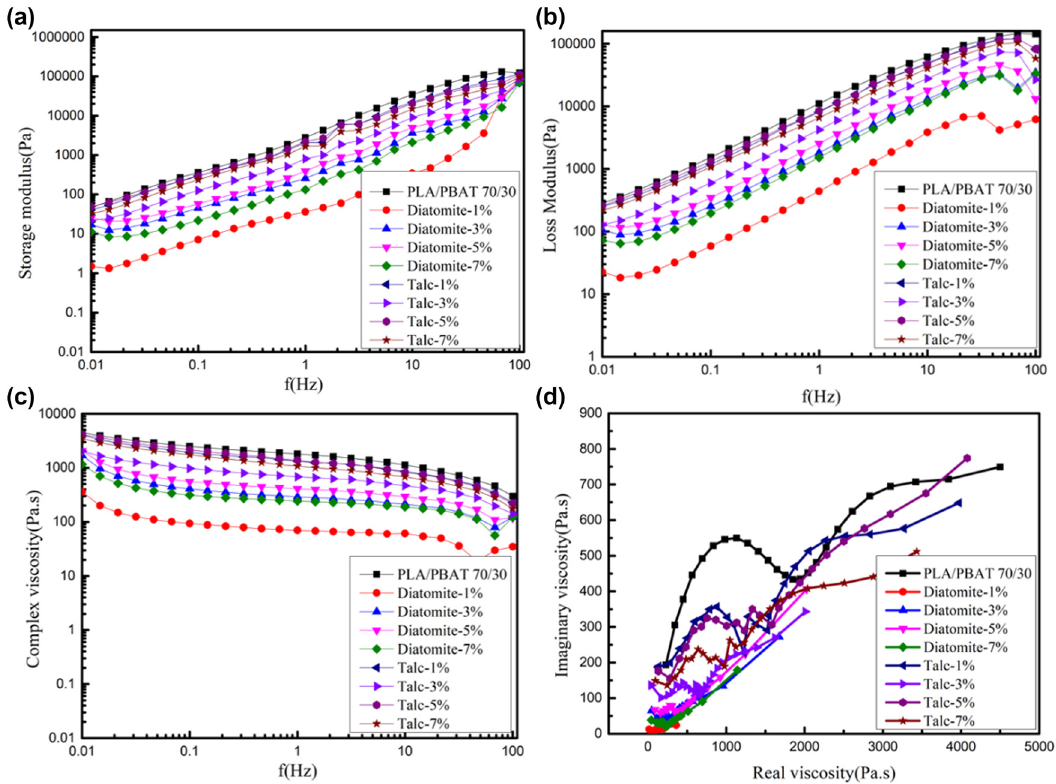
Figure 4: E ff ect of diatomite and talc loadings on the rheological behaviors of the blends: ( a ) storage modulus, ( b ) loss modulus, ( c ) complex viscosity, and ( d ) cole – cole